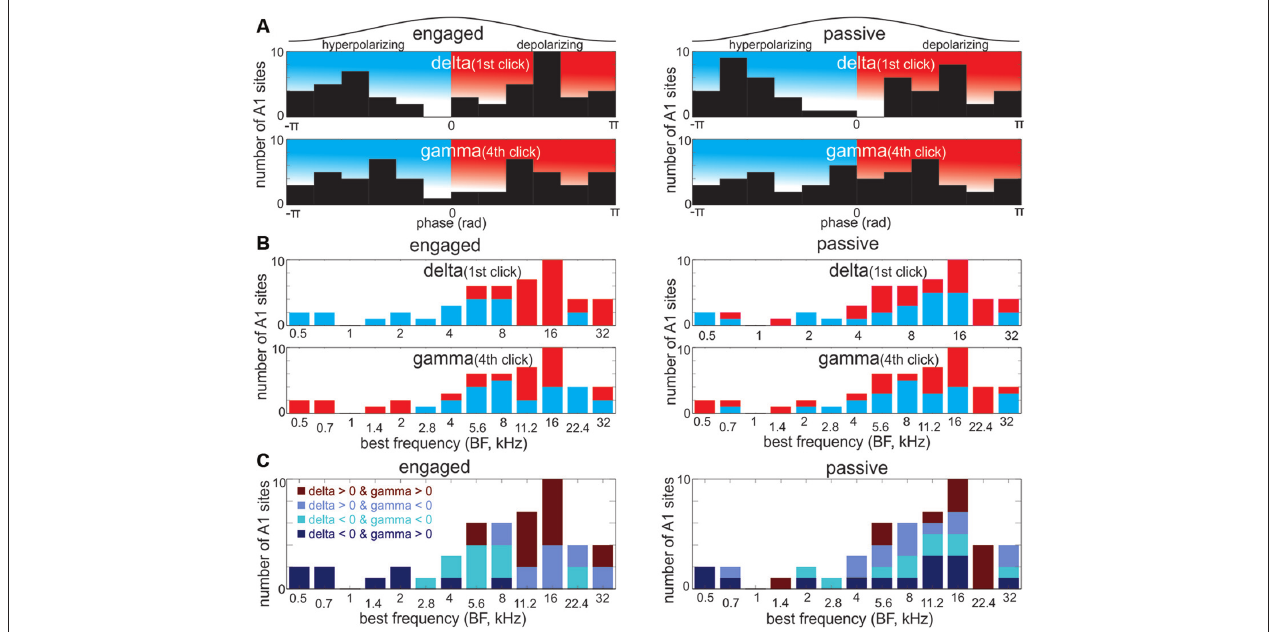
FIGURE 5 | The distribution of pre-stimulus delta and gamma oscillatory phases across differently tuned A1 regions. (A) Histograms show the distribution of delta phases measured at the onset of the first click (0 ms) and gamma phases measured at the onset of the fourth click (90.9 ms) in the engaged and passive conditions. Phases were measured at the delta and gamma frequencies that correspond to the stimulus onset asynchrony (SOA) between and repetition rate within click-trains (1.6 and 33 Hz respectively). Black traces above the histograms represent one oscillatory cycle. Therefore, the histograms illustrate where in the delta/gamma cycles the first/fourth clicks tend to occur. It is apparent that both delta and gamma phases in the engaged, and delta phases in the passive condition have a bimodal distribution, indicating that click related inputs tend to fall on either of two preferential phases either the upward deflection (hyperpolarizing phase) or downward deflection (depolarizing phase). (B) The BF distribution of sites with hyperpolarizing and depolarizing pre-stimulus phases. Note that sites with depolarizing pre-stimulus delta phases in the engaged condition have high BFs. Also note that the gamma phases in high frequency tuned sites are mixed, while low frequency sites have depolarizing gamma phases at the onset of the fourth click. Importantly, the BF distribution of sites with depolarizing and hyperpolarizing delta and gamma phases is markedly different only in the engaged condition. (C) Theoretically, delta and gamma phases can combine in four different ways, and as the histograms show, they indeed do. Note that the distribution of sites with depolarizing delta and gamma phases ( delta > 0 and gamma > 0) in the engaged condition appears to be very similar to the BF distribution of sites with no significant engagement related suppression ( Figure 2D